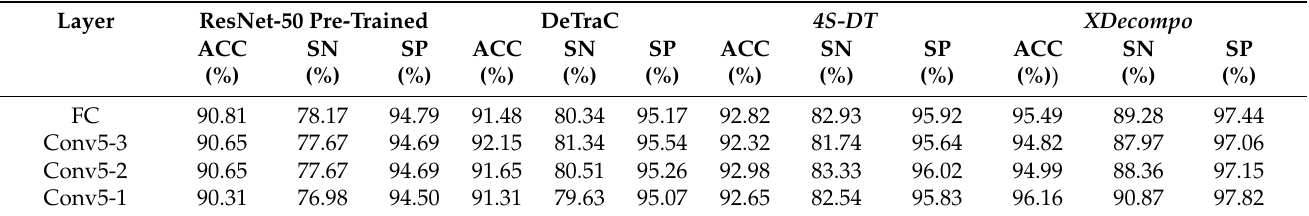
Table 7. Overall classification performance of each model on testing set of the CRC